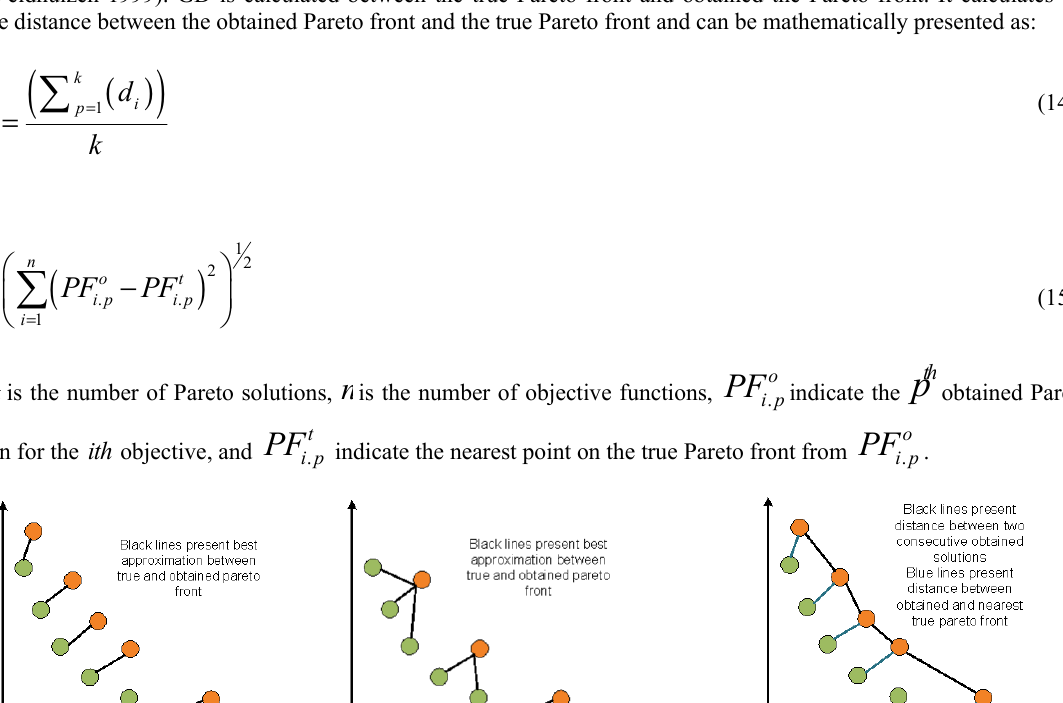
Fig. 5. Schematic representation of (a) Generational Distance (GD) (b) Inverse Generational Distance (IGD) and (c)